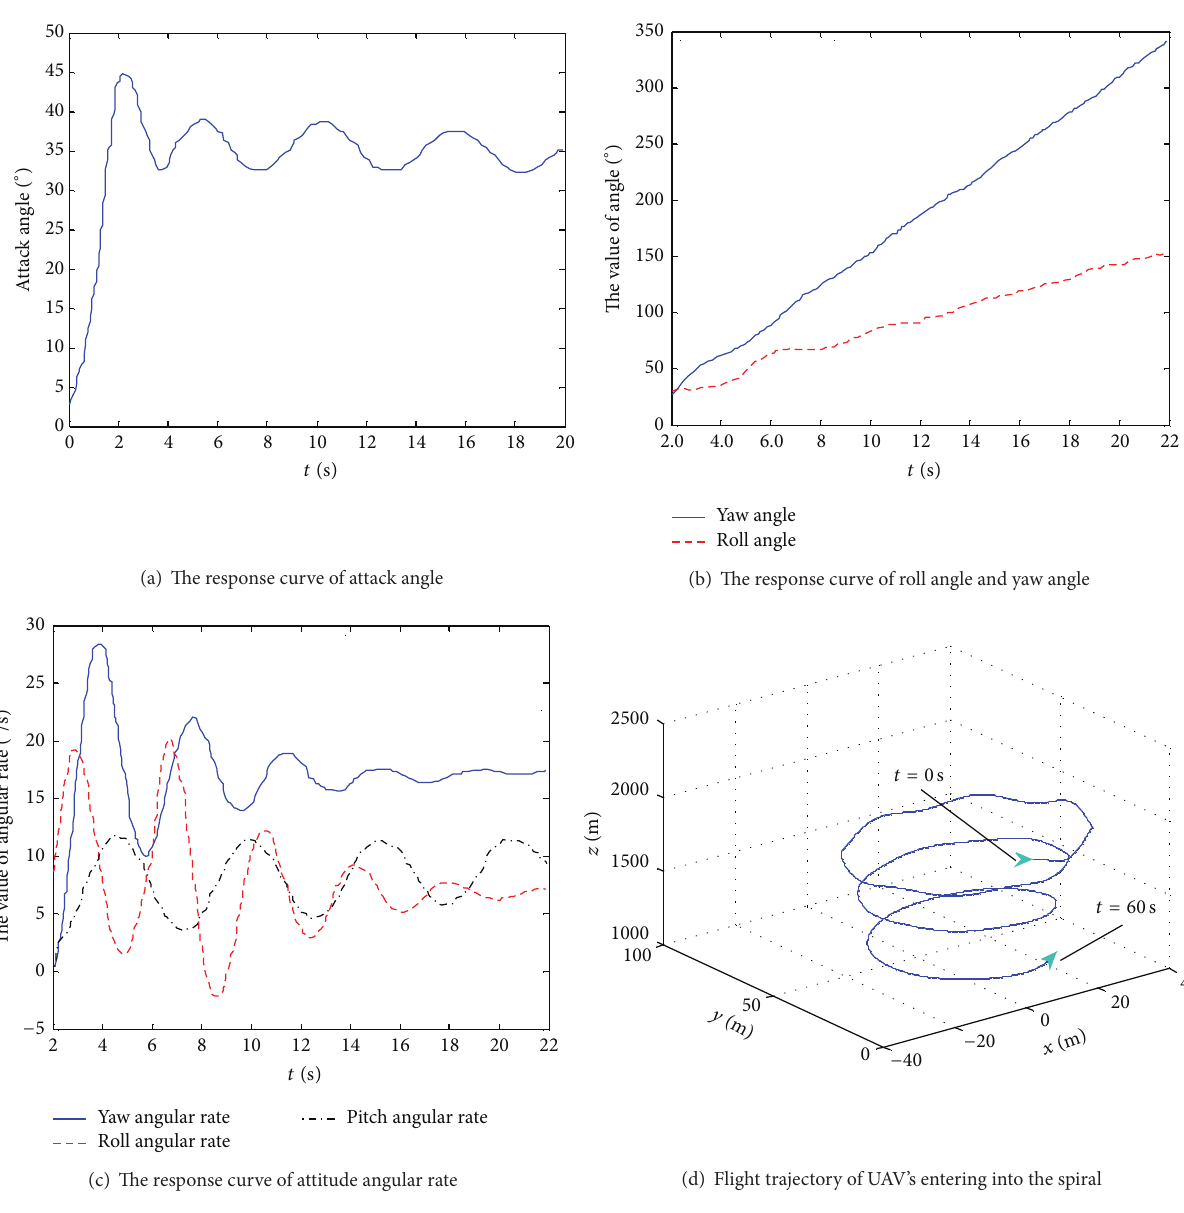
Figure 5: The dynamic process of UAV’s entering into the